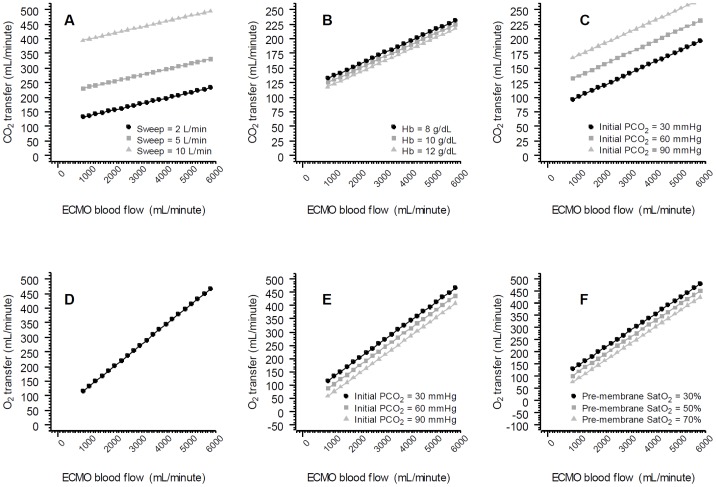
Mathematical marginal model exploring the O2 and CO2 transfers according to the progressive elevation of ECMO blood flow.The default variables were: sweep flow = 2 L/minute, initial pre-membrane SatO2 = 30%, initial pre-membrane PCO2 = 30 mmHg and initial hemoglobin = 8.0 g/dL. The marginal model is derived from the multivariate mixed model. Panel A shows the CO2 transference resultant from sweep flow variation. Panel B shows the CO2 transference resultant from hemoglobin variation. Panel C shows the CO2 transference according to the initial PCO2 variation. Panel D shows the O2 transference resultant from ECMO blood flow variation. Panel E shows the O2 transference resultant from initial PCO2 variation. Panel F shows the O2 transference according to the initial pre-membrane SatO2 value.